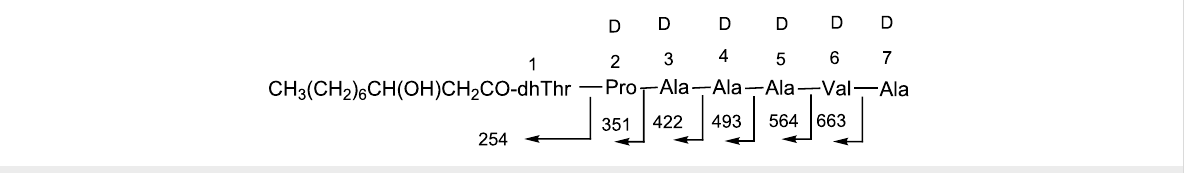
Figure 5: Fragment obtained by acid hydrolysis and each amino acid was exclusively D-configuration (peptide fragment b ions).